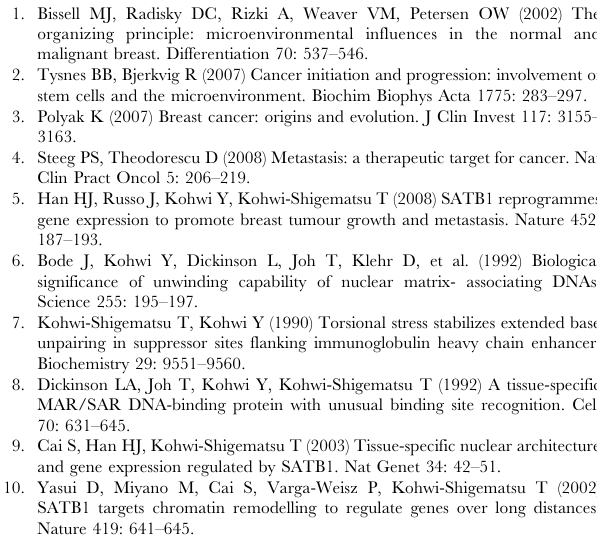
Figure S2 A ) Average weight (gram) of tumors isolated 40 days after mammary fat pad injection with MCF10A-1 vector control, pLXSN-SATB1 pool, and clone-1. (n= 4 to 5 mice per group). Error bars indicate s.e.m. B ) Incidence of total palpable tumors in clone-1-TUM and clone-1-TUM(SATB1-shRNA) after mammary fat pad injection. This indicates a delay in onset of tumor formation for clone-1-TUM (SATB1-shRNA) cells compared to clone-1-TUM during the first week.